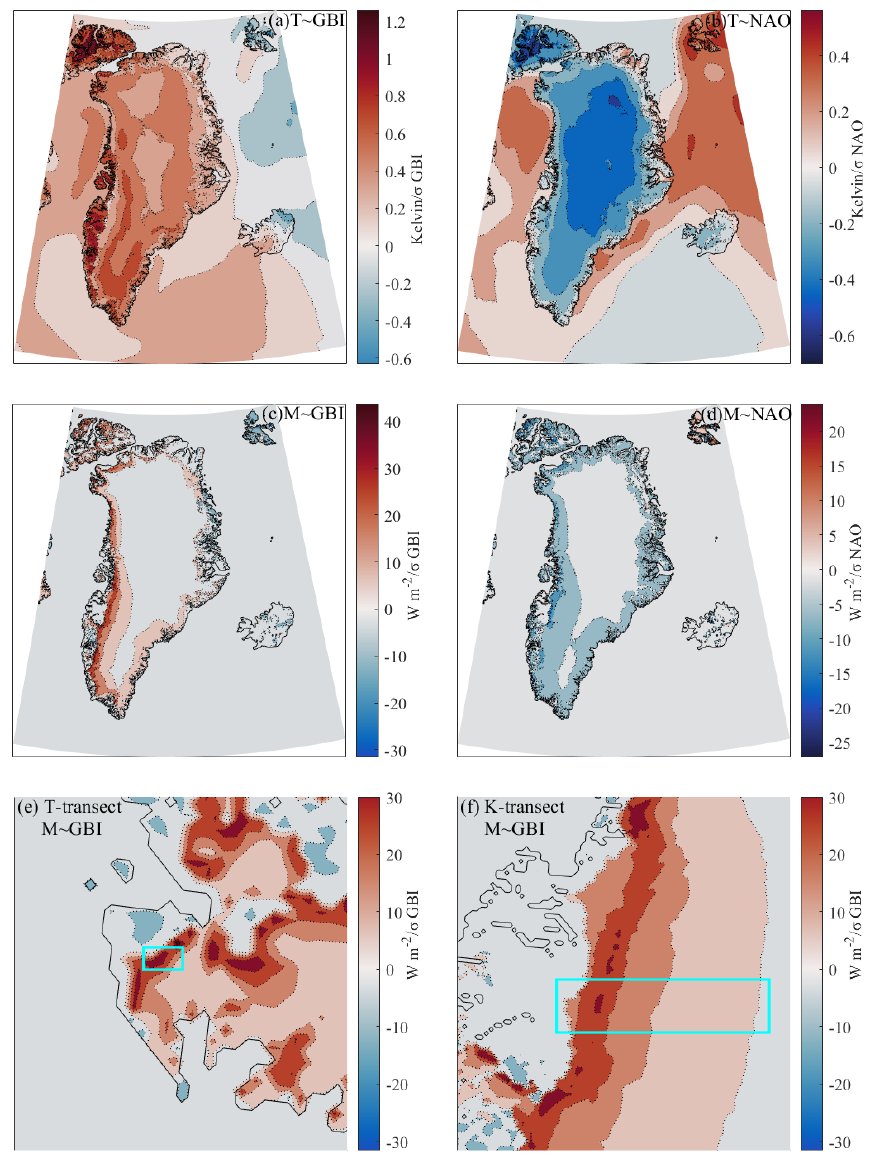
Figure 12. Regression slope of 2000–2018 JJA average 2m temperature ( T 2m ) from RACMO2.3 with (a) GBI and (b) NAO index and melt flux from RACMO2.3 with (c) GBI and (d) NAO index. The regression slope maps are scaled to show the 2m temperature change from RACMO2.3 (in kelvin) and melt flux change (in Wm − 2 ) for a 1 standard deviation change in GBI and NAO circulation index. Panels (e) and (f) are enlarged slope value images for T-transect and K-transect of JJA average melt fluxes from RACMO2.3 with GBI. Solid black lines are land–sea